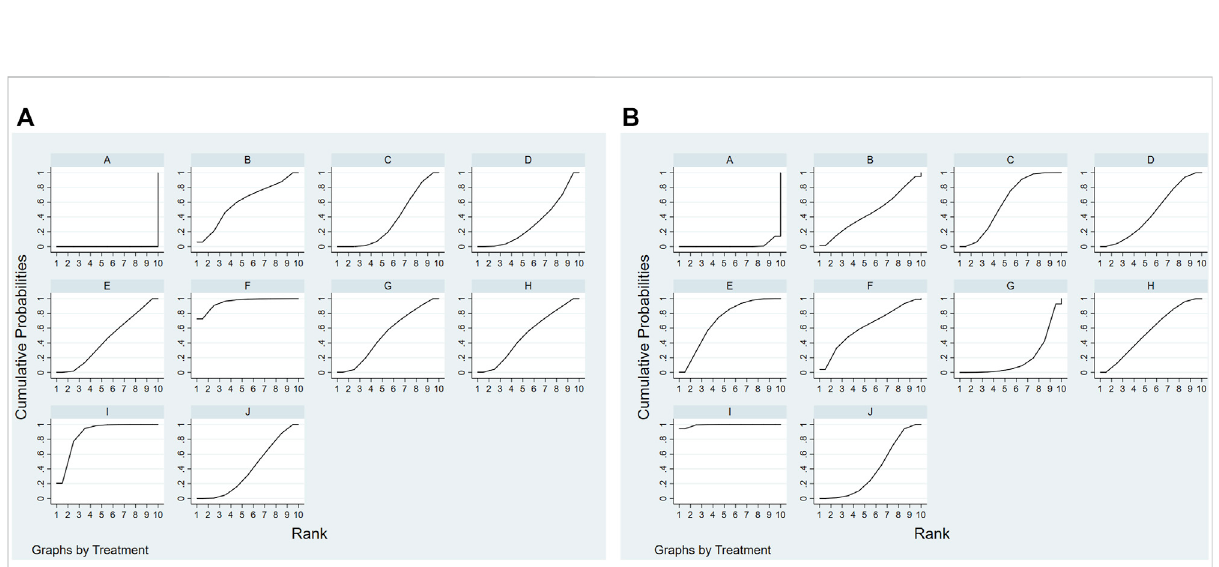
FIGURE 5 Rank of the cumulative probabilities for outcomes: Median nerve. (A) Median motor nerve conduction velocity; (B) median sensory nerve conductionvelocity.[ (A) :ME; (B) ME+CXQ; (C) ME+DH; (D) ME+DSCXQ; (E) ME+DZHS; (F) ME+DZXX; (G) ME+GGS; (H) ME+HH; (I) ME+KDZ; (J) ME +